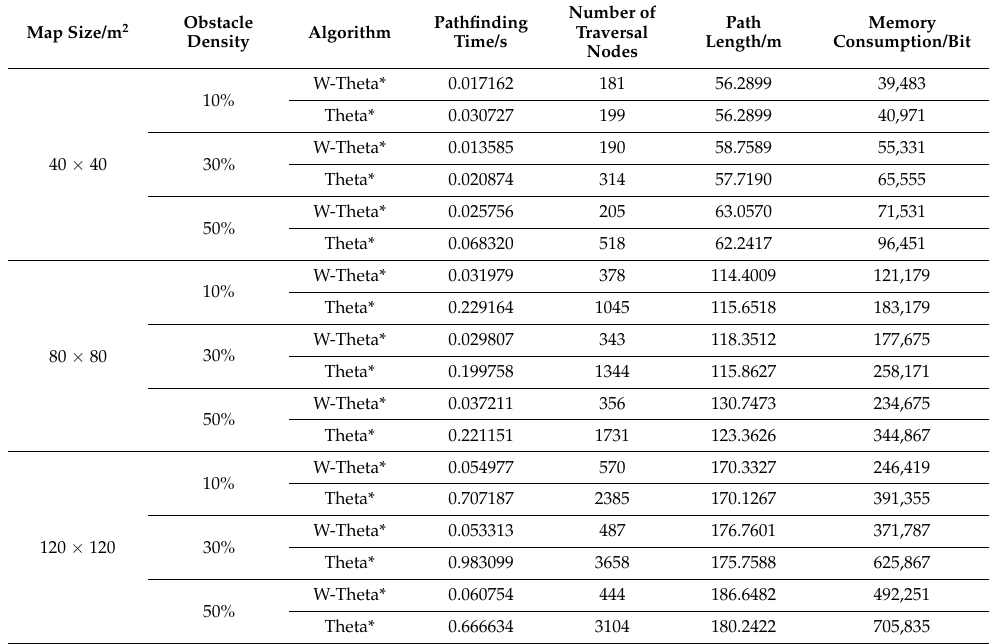
Table 1. Experimental data table of W-Theta* algorithm and Theta* algorithm for maps with three sizes and different obstacle densities.